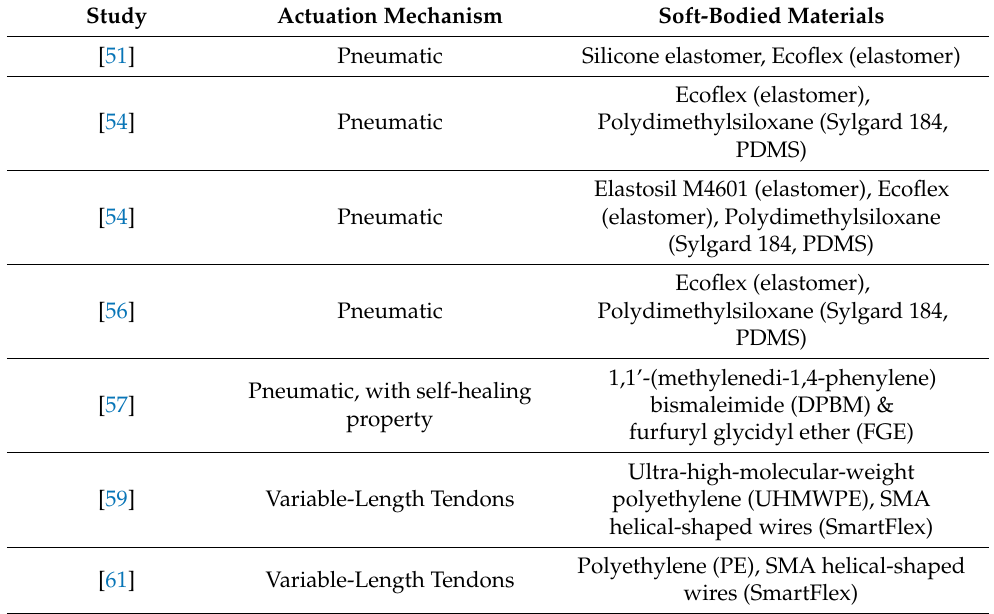
Figure 2. ( a ) An example of a PN soft-robotic gripper manipulating an object. The gripper also has color-changing ability due to covalent bond activation, courtesy of Gossweiler et al. [56] with permission obtained from ACS Publications; ( b ) an example of variable-length tendon-driven octopus- inspired robotic arm, which utilizes SMA springs in both the transverse and longitudinal direction; courtesy of Cianchetti et al. [61], open access article; and ( c ) examples of ionic EAP actuator motion under different DC voltages, courtesy of Park et al. [66], open access article. Table 2. Summary of different soft-robotic technologies and their